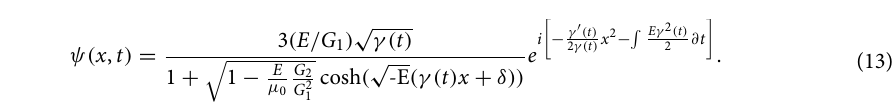
Figure 1. Quantum droplets in free space and external harmonic trap. Variation of density profiles (a) in free space w.r.t. changing magnitude of mean field interaction strength ( G 2 ) for the physical parameters: γ( t ) 1 , along with G 2 0.99 (dotted purple), 0.9999 (dotdashed blue), 0.999999 (dashed red) 2 / 9 , G 1 E = − = = − and 0.9999999 (thick black line); (b) in presence of regular harmonic trap (dotdashed blue line) and expulsive harmonic trap (dashed line red) for the physical parameter values: γ 0 1 . Here, the free space quantum droplet profile is depicted with black line for γ( t ) 0.9999 and t G 2 = = 0.9999 G 2 =